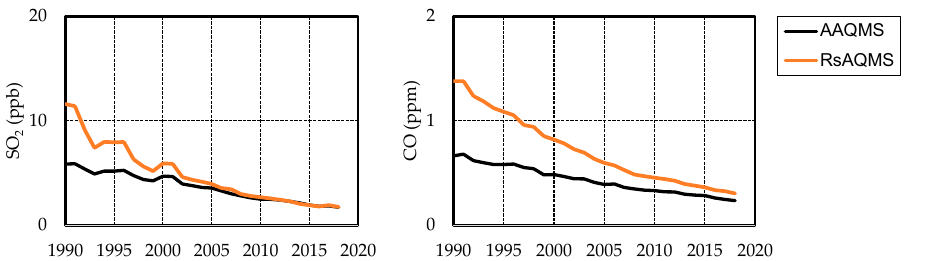
Figure 7. Annual average SO 2 and CO concentrations at the AAQMS and RsAQMS of the nation from 1990 to 2018.